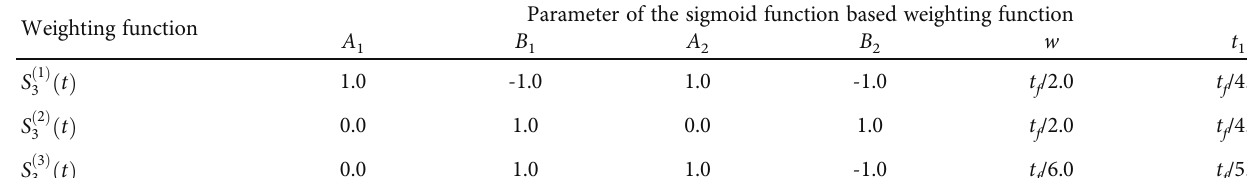
ð 0 Þ = 20 ° , γ = − 70 ° . f m ð t Þ . 3